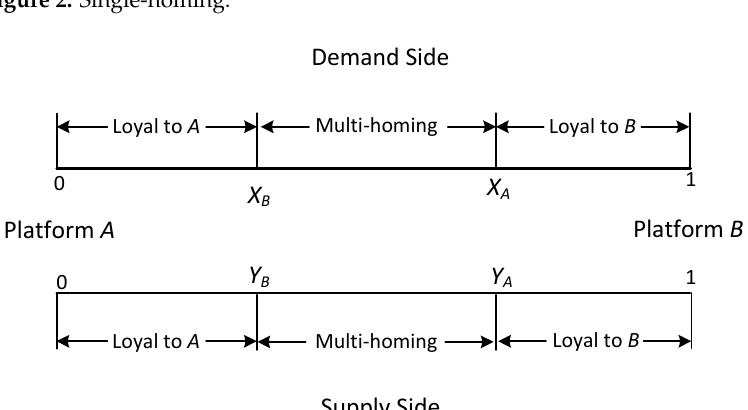
Figure 2. Single-homing.